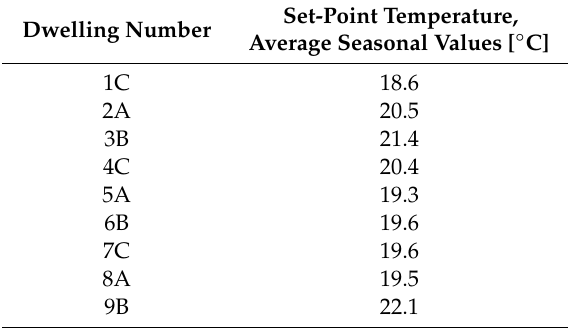
Table 5. Average seasonal values of set-point temperature used for the simulation of the base scenario. Dwelling Number